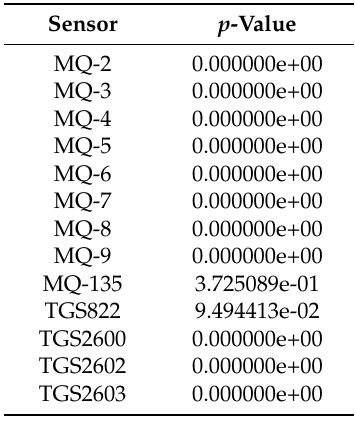
Table 4. Values of the p -values for each gas